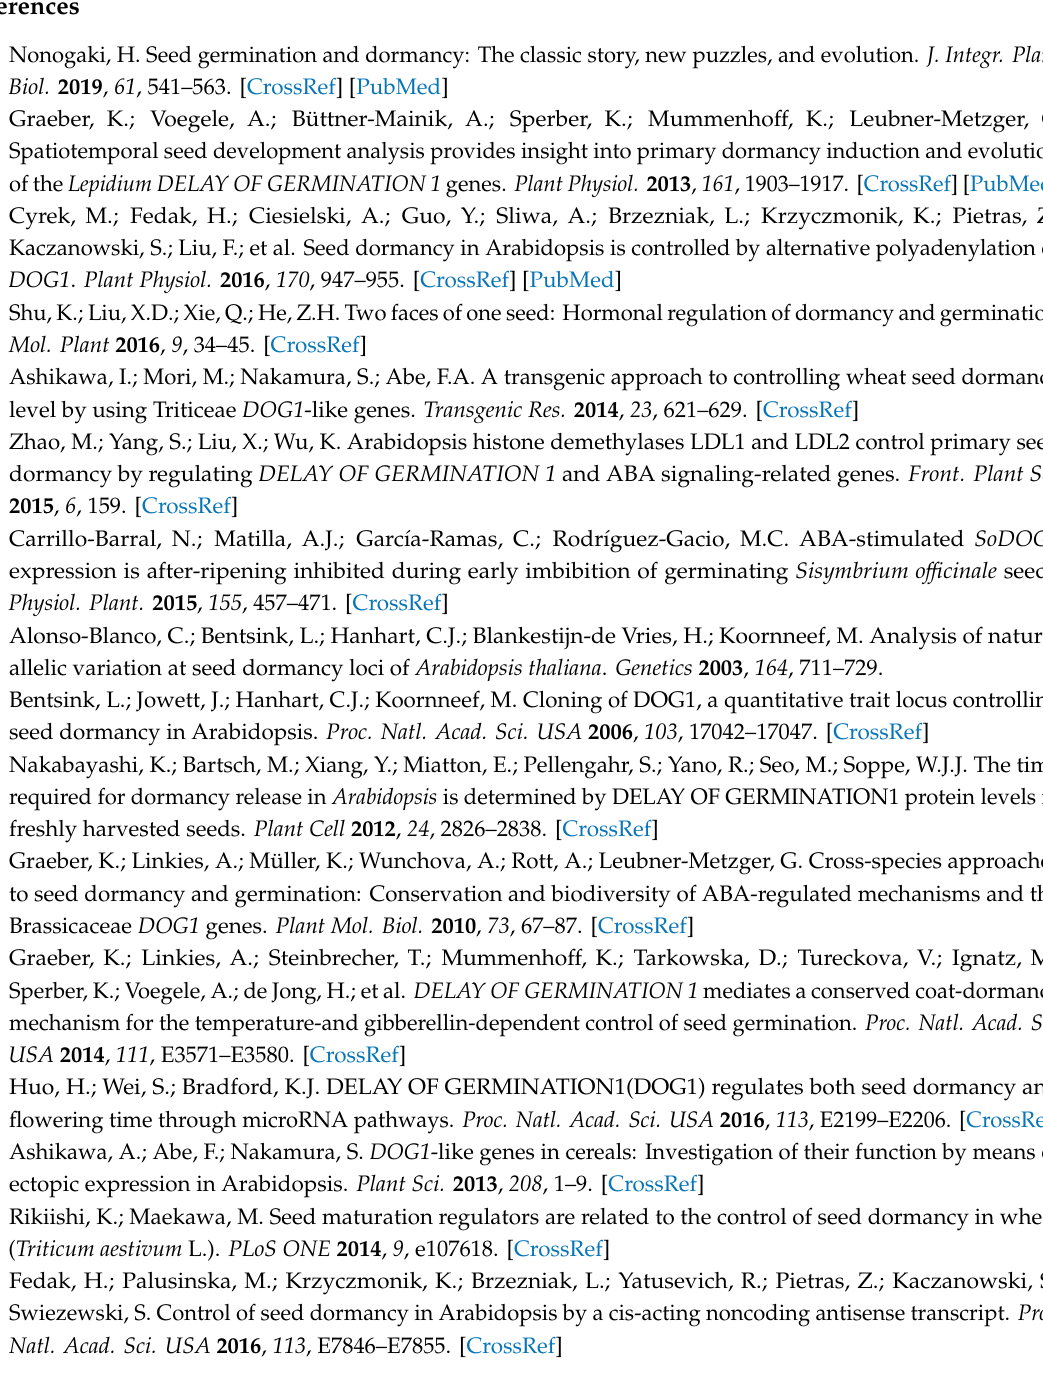
Figure S1: Alignment of deduced DOG1 and DOG1-like amino acid sequences used to create the phylogenetic tree (Figure 1). Sequences were aligned using MEGA-X software and the Clustal-W algorithm, Table S1: Genes and proteins included in the phylogenetic